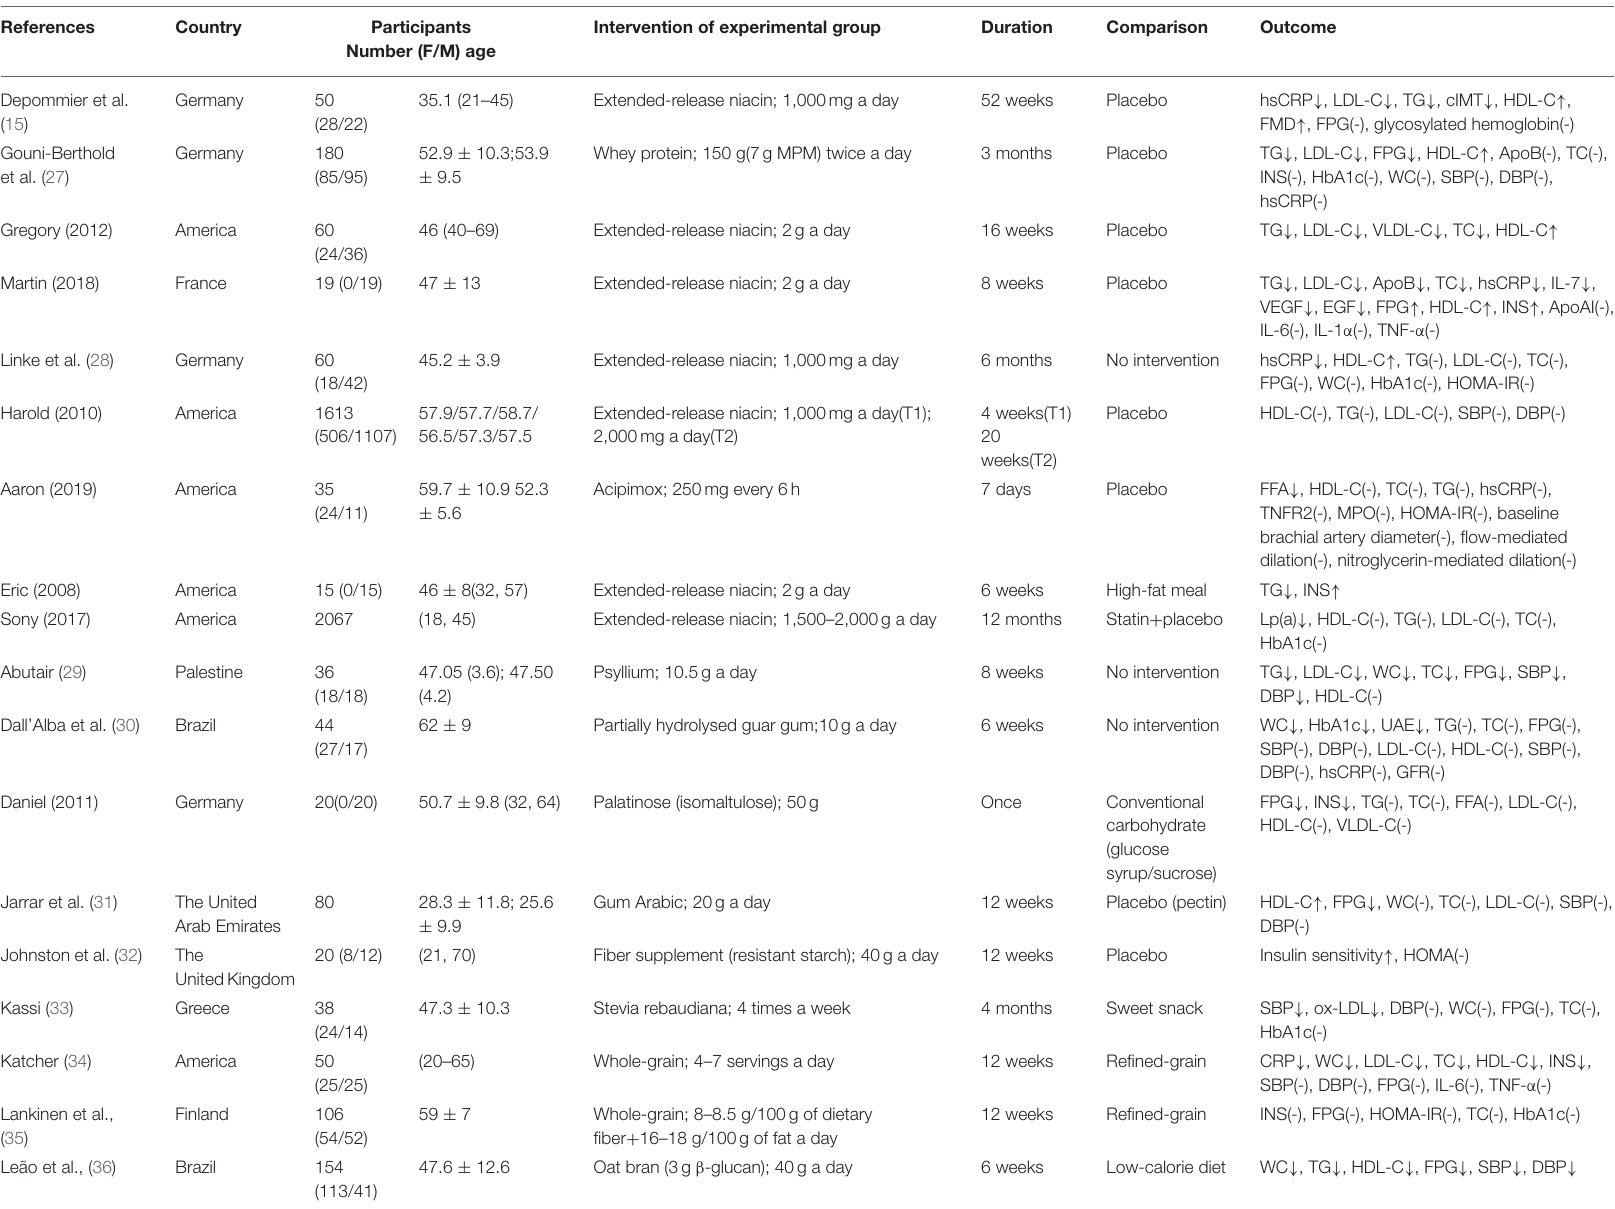
TABLE 1 | Characteristics of included